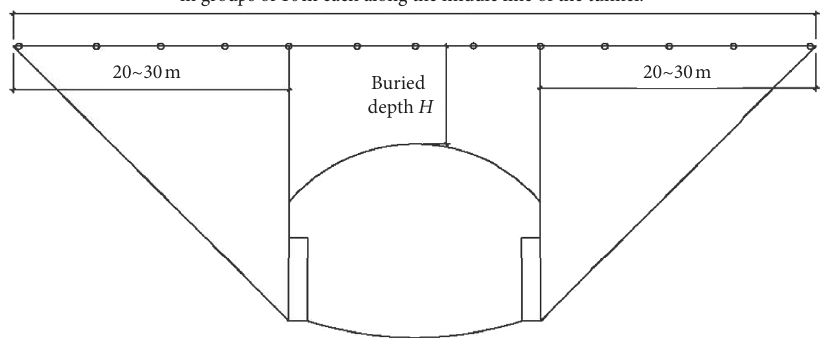
Figure 4: Design monitoring cross